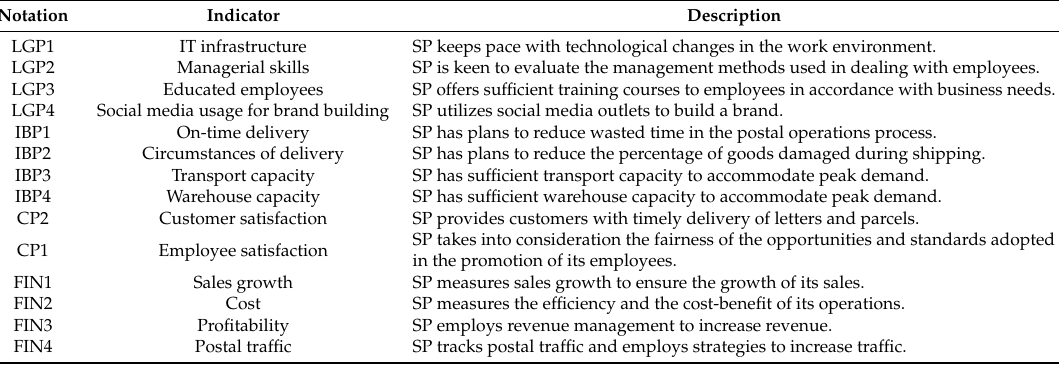
Table A1. The survey: Responses to the following questions ranged from 1 = “totally disagree” to 5 = “totally